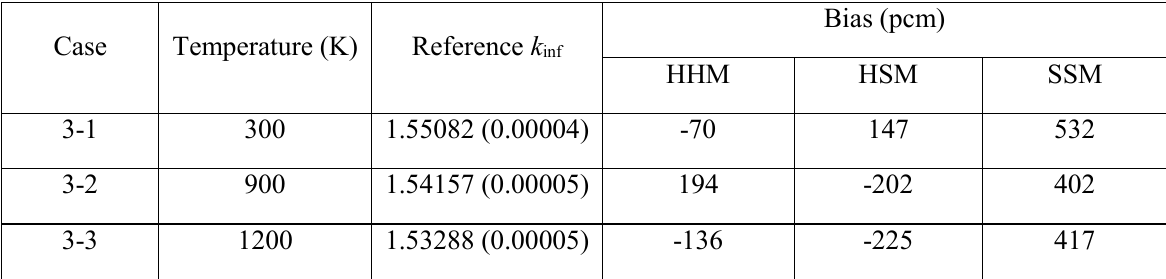
for different inf